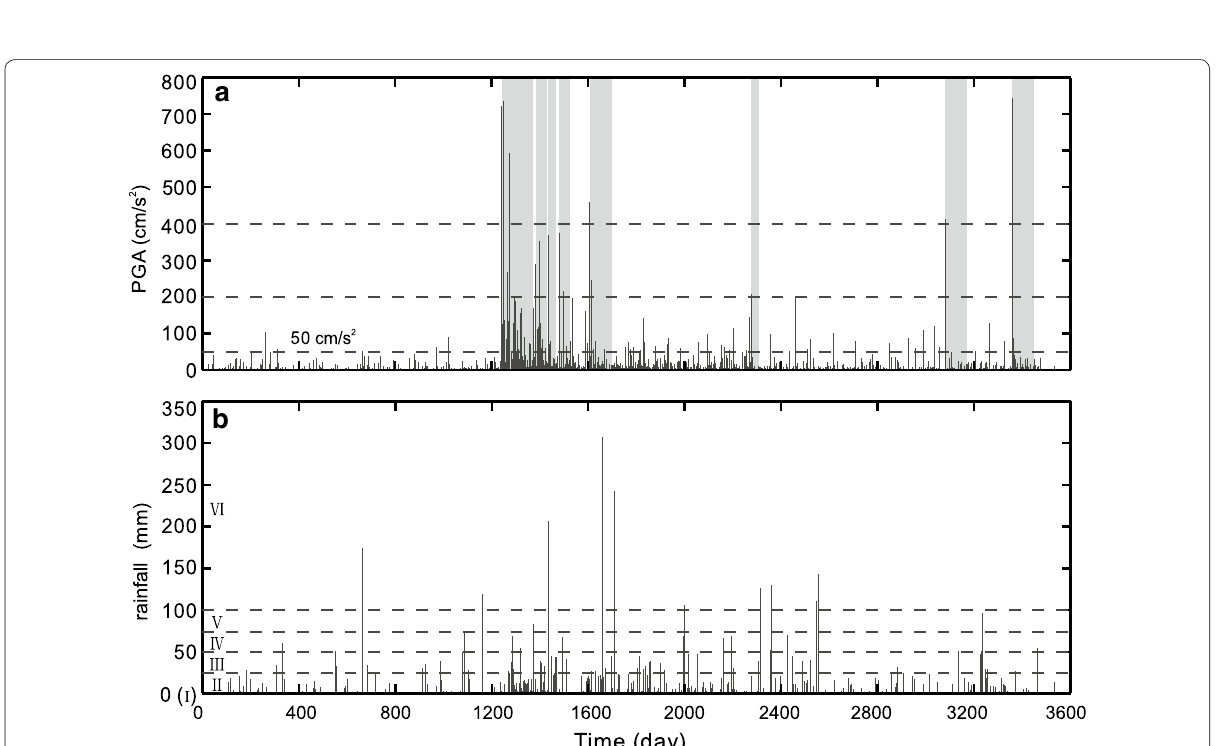
Fig. 2 a PGA of seismic records logged at IBRH13. The horizontal dashed lines represent 50, 200 and 400 cm/s 2 , respectively, and the gray areas represent the influence time of strong motions. b Daily rainfall for IBRH13. The horizontal dashed lines represent 25, 50 and 100 mm, respectively. The zeroth day of the horizontal axis indicates the start date when sampling frequency of seismographs at IBRH13 is changed to 100 Hz (17 October